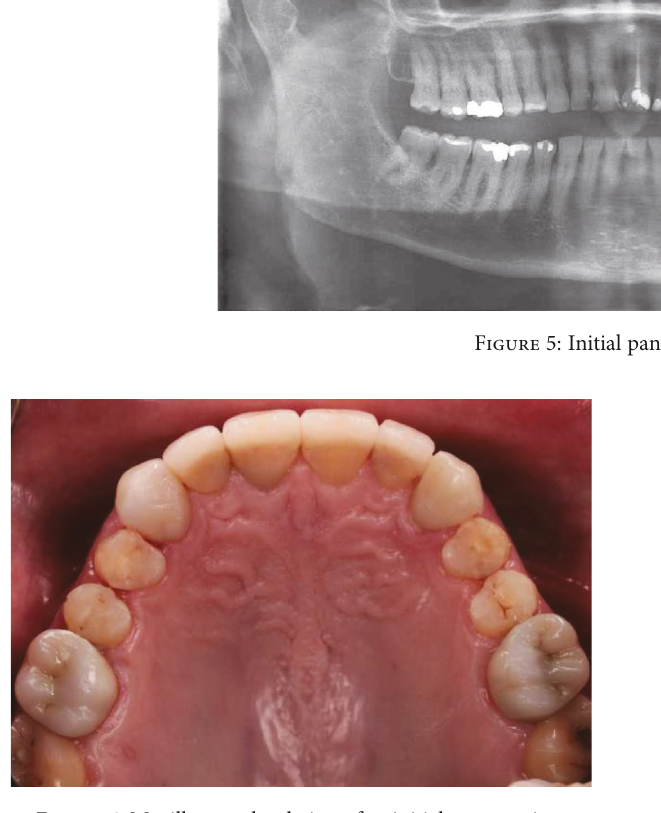
Figure 6: Maxillary occlusal view after initial cementation.